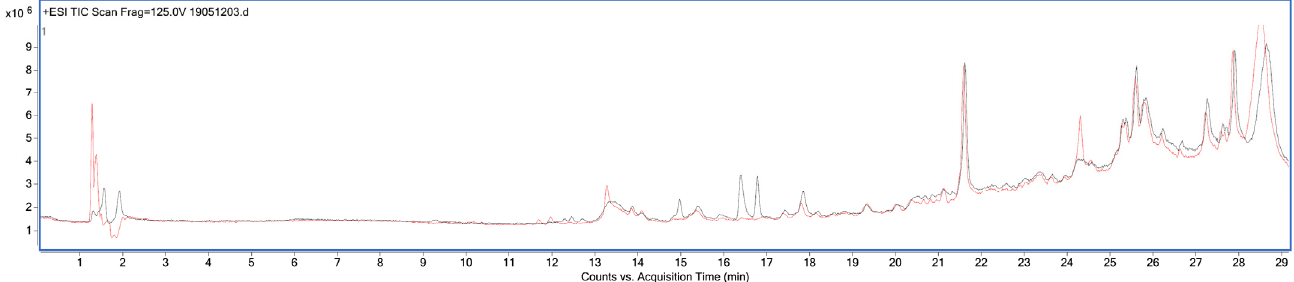
Figure 9. Chromatographic profile of a methanol blank (grey line) and of the sample (red line).